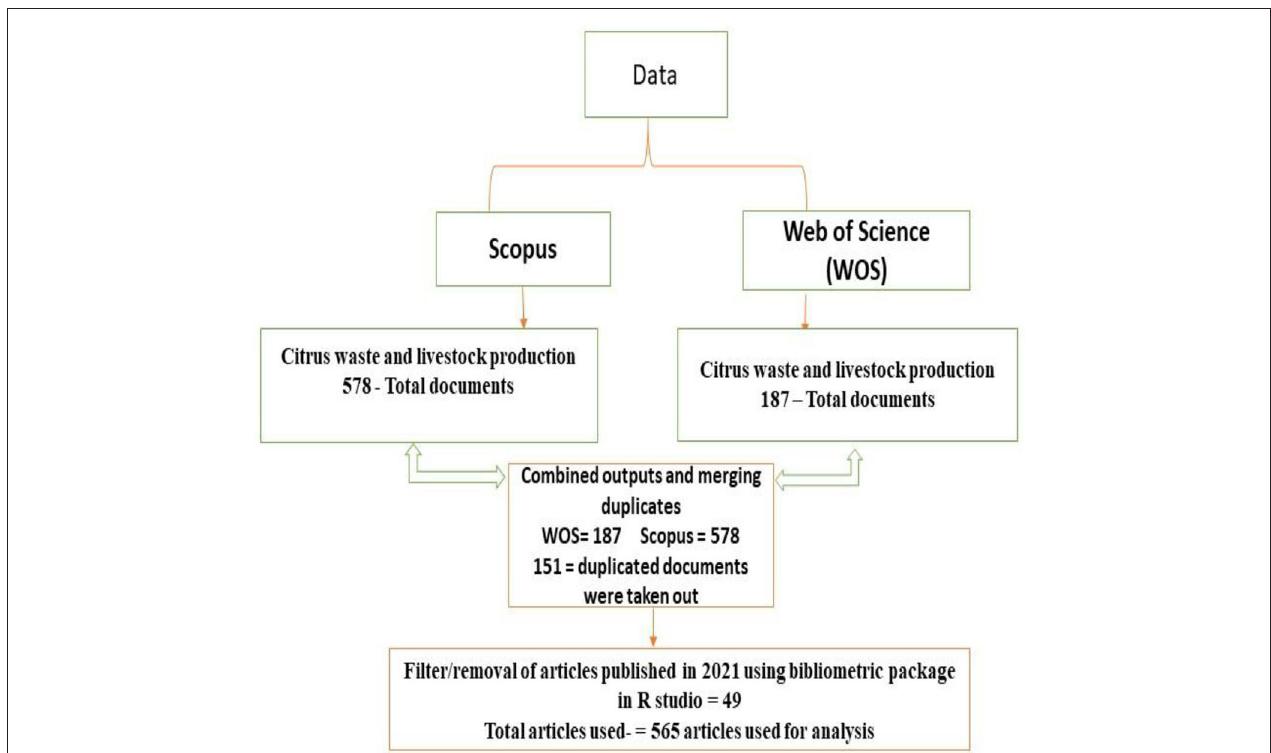
FIGURE 1 | Diagrammatic representation showing the inclusion and exclusion criteria for out-puts selection.